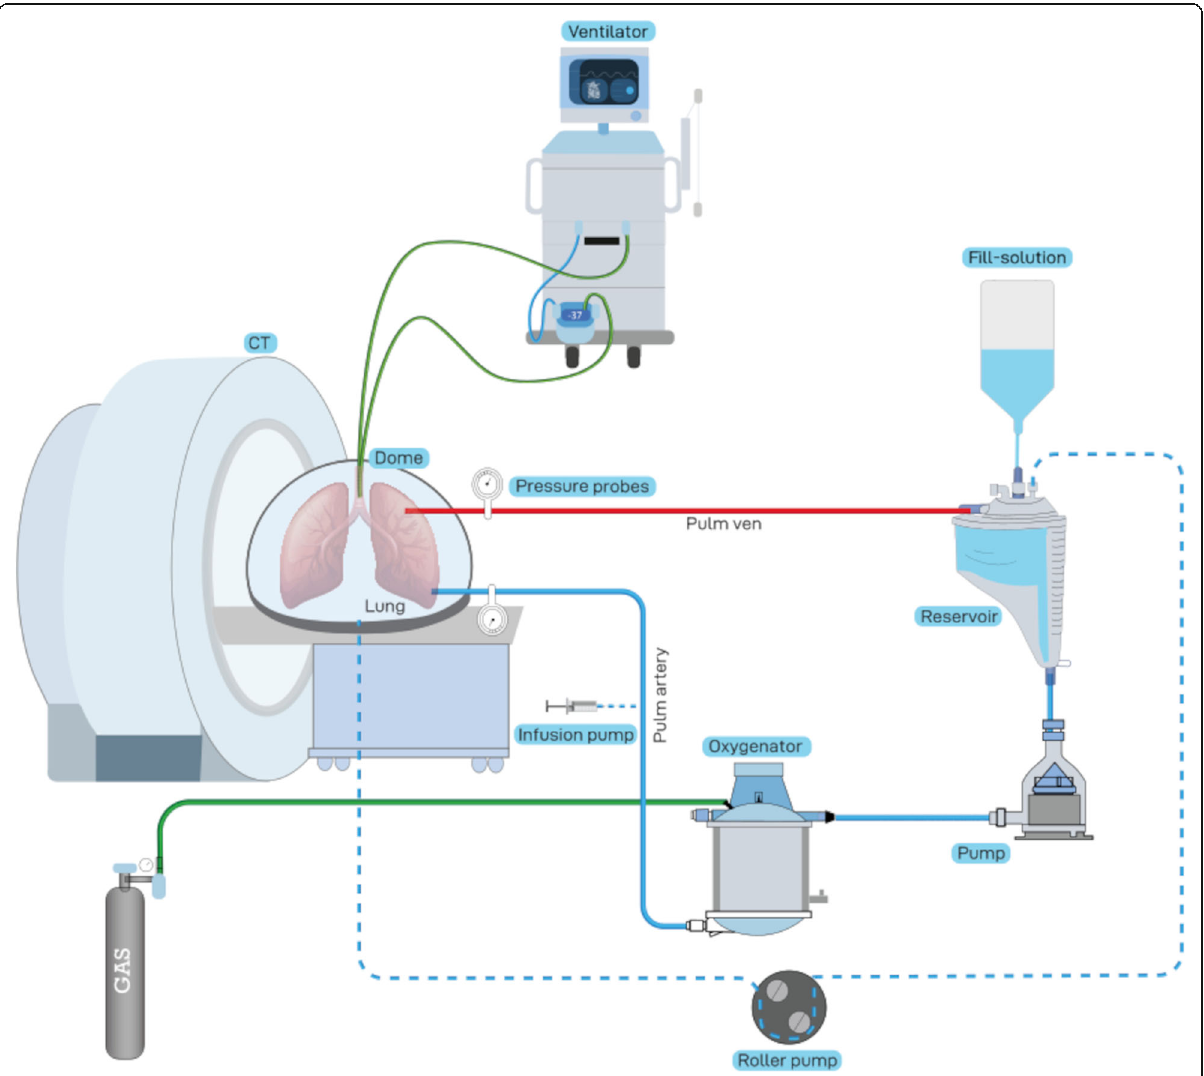
Fig. 1 Schematic diagram of the experimental setting. The lung lobe (represented by a double lung for ease of understanding) is placed in a plexiglass dome in the computed tomography (CT) gantry. Green lines mark ventilation/gas tubes. The dashed line corresponds to the venous return of leaked perfusate. Degradable starch microspheres and contrast agents are added to the pulmonary artery. The extracorporeal membrane oxygenator is placed in front of the CT gantry and the ventilator is placed behind the CT gantry. The contrast agent injector, a monitor for pulmonary artery pressure measurements and the automated syringe infusion pump are also